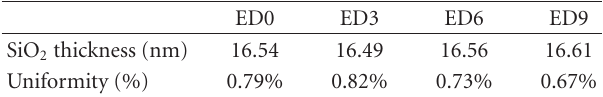
Table 3: Comparison of SiO 2 thickness and uniformity of di ff erent etching depths.